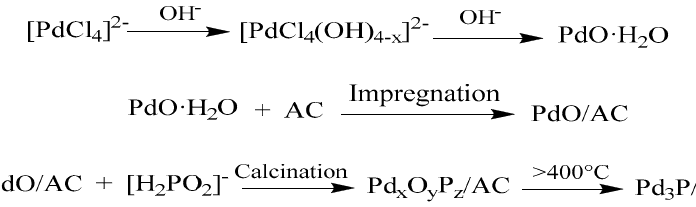
Figure 7. Generation mechanism of palladium phosphide.